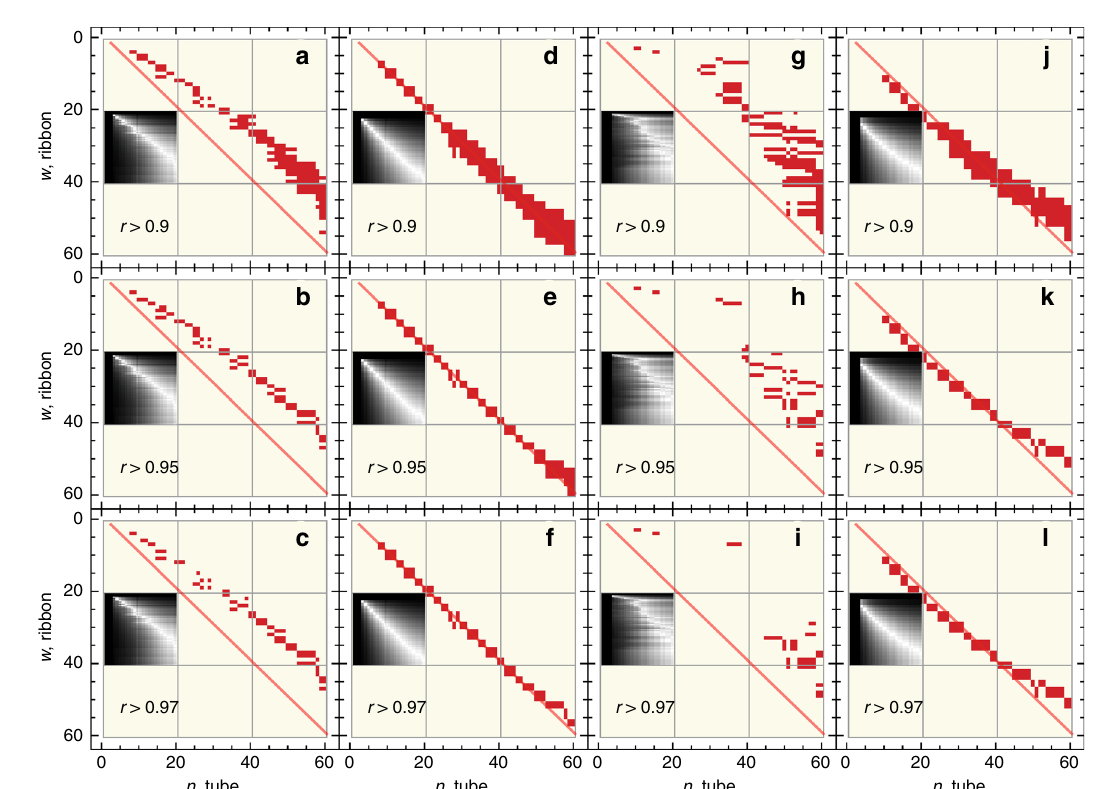
Fig. 2 Optical resonance linear correlation. LCC maps for the optical resonances of armchair SWCNTs and ZGNRs: a – f single-parameter Partoens 2006 TBM and g – l fi tted TBMs from Table 1. a – c and g – i LCC maps include the edge-to-bulk state transitions in ZGNRs. d – f and j – l LCC maps include only bulk- bulk state transitions in ZGNRs. Insets show full indiscriminate LCC maps, where the color gradient from black to white corresponds to the ascending LCC values. The red regions signify r > r , where r is the threshold value for the linear correlation coef fi cient. Red semi-transparent lines are the reference th th lines given by n ¼ w þ 1. The lowest energy peak is excluded from the armchair SWCNTs datasets in all (ii) the LCC between bulk-bulk ZGNR resonances and armchair